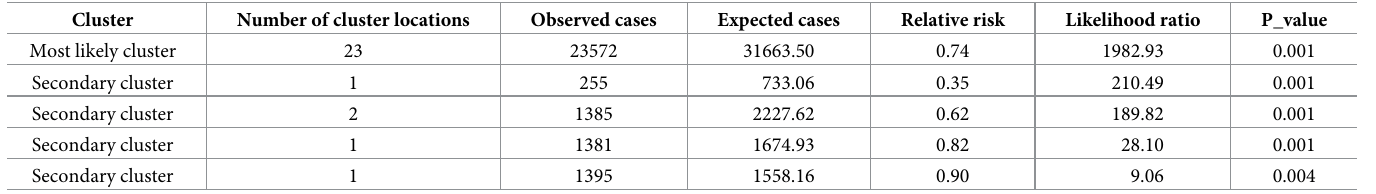
Table 1. Most likely and secondary spatial clusters of low health service utilisation detected by purely spatial analysis in Dale and Wonsho districts, Sidama, south- ern Ethiopia, 2017/18. Cluster Number of cluster